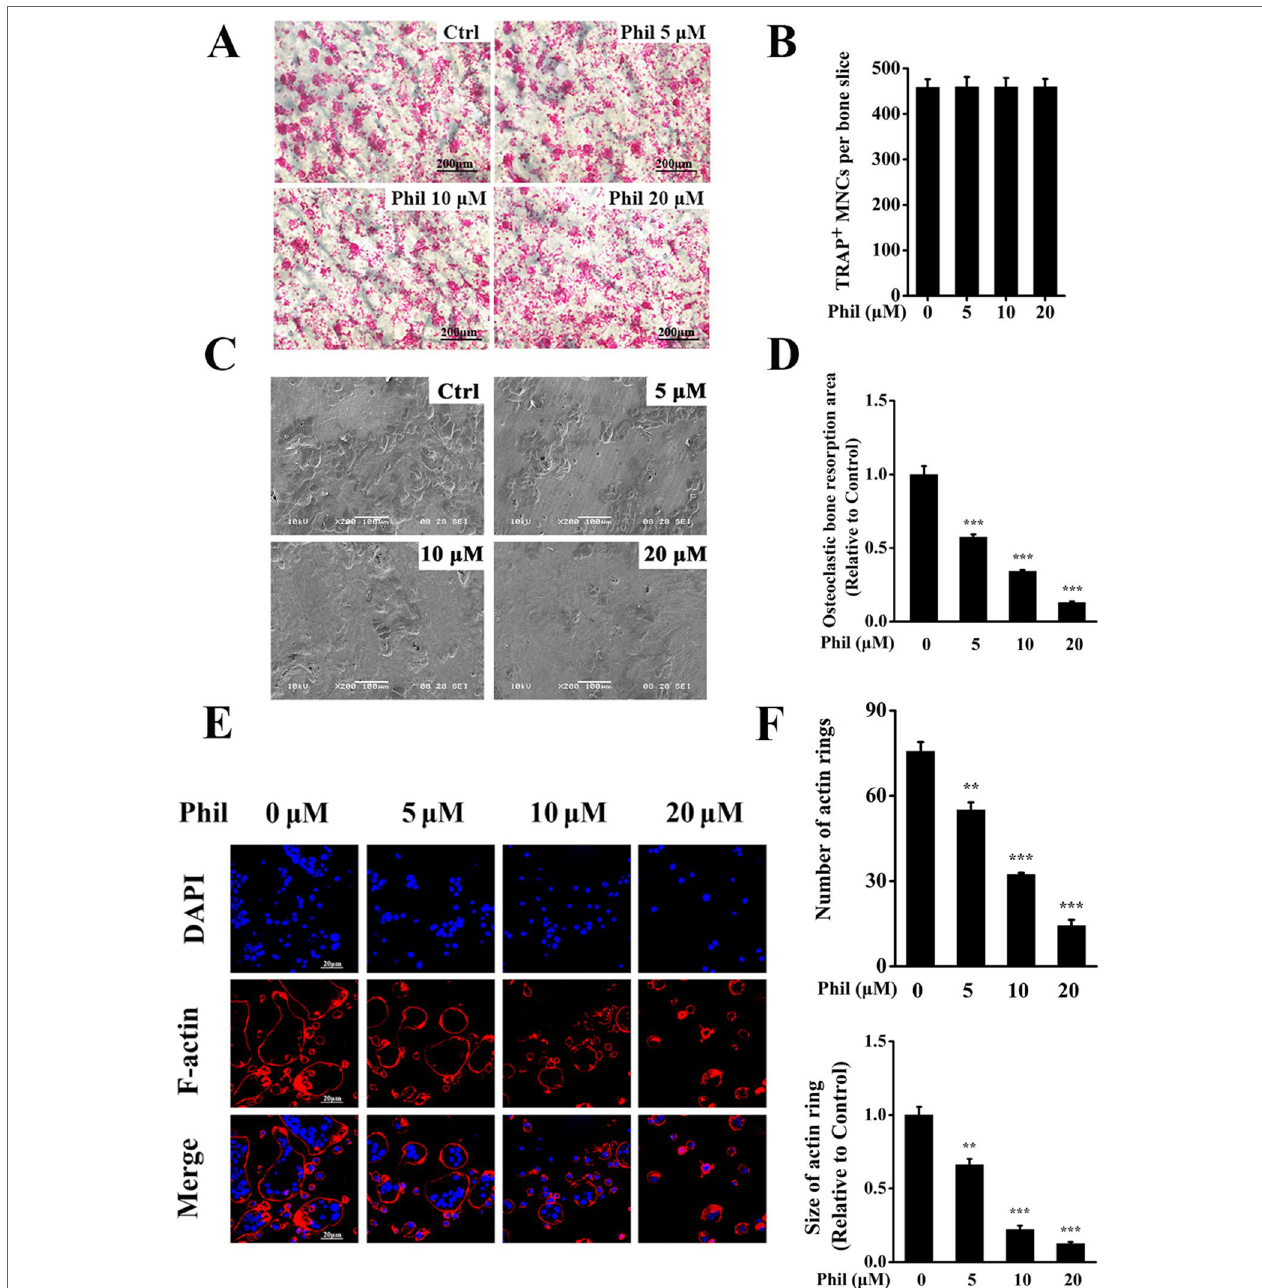
FIGURE 3 | Phil impairs osteoclastic resorptive activity and F-actin ring formation. (A) Mature osteoclasts cultured on the bone slices were treated with different concentrations of Phil and then stained for TRAP activity. ( B ) The quantitative analysis of the number of TRAP + osteoclasts (≥3 nuclei) from (A) indicated that Phil had no cytotoxic effect on mature osteoclasts. (C) After removal of the cells on bone slices, the resorption pits were visualized by scanning electron microscopy. (D) The area of resorption pit was calculated using ImageJ software (n = 3). *** P < 0.001 relative to RANKL-induced, Phil-untreated group. (E) The effect of Phil on F-actin ring formation was assessed using immunofluorescent staining. (F) The number and size of F-actin rings were calculated (n = 3). ** P < 0.01 and *** P < 0.001 relative to RANKL-induced, Phil-untreated